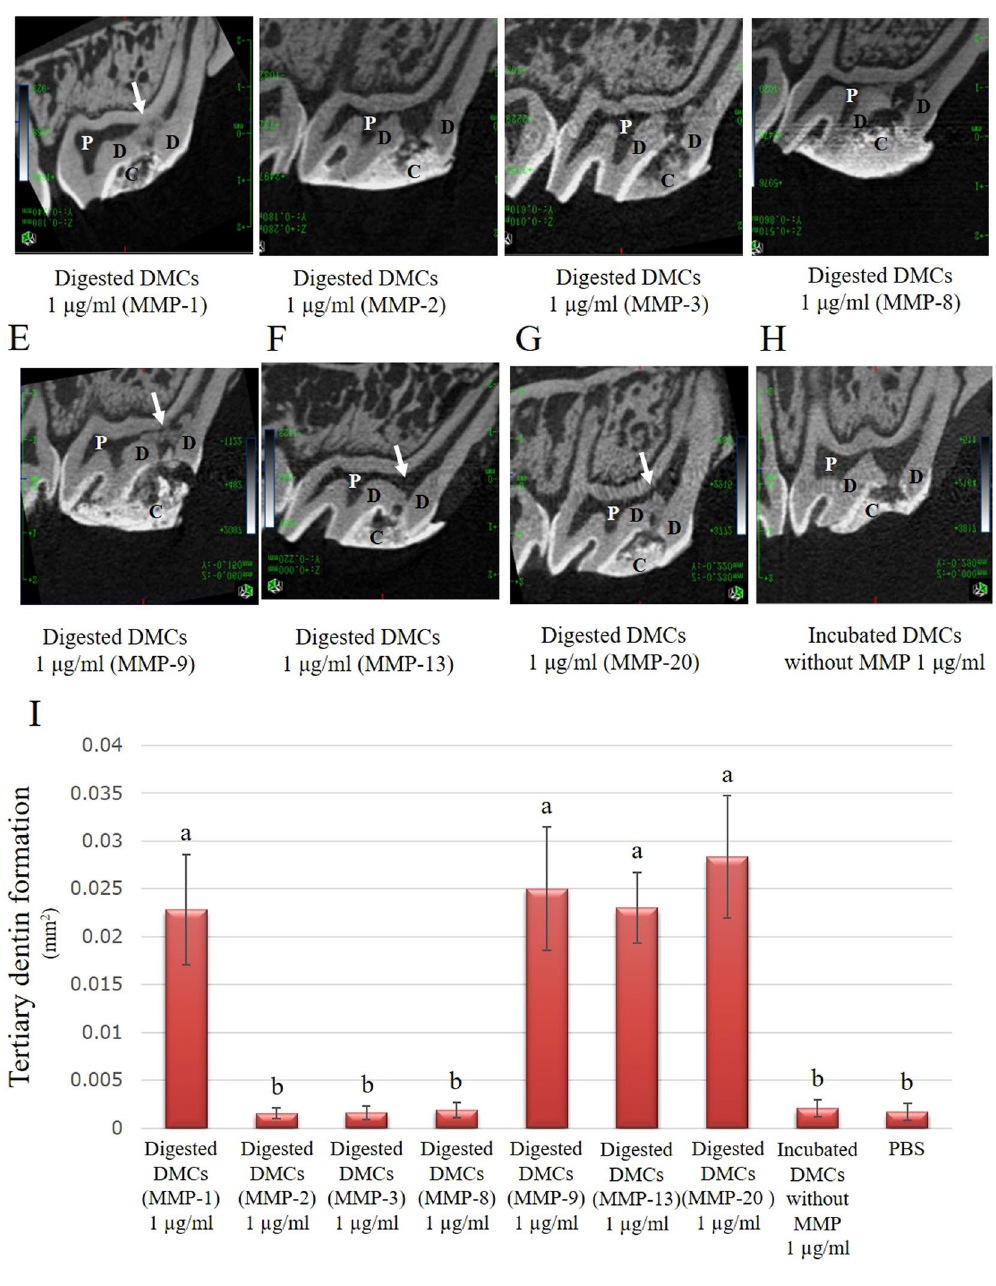
Figure 7. Micro-computed tomography (CT) images of tertiary dentin formation 28 days after direct pulp capping using 1 µ g/ml of dentin matrix components (DMCs) treated with matrix metalloproteinase (MMP)-1 ( A ), MMP-2 ( B ), MMP-3 ( C ), MMP-8 ( D ), MMP-9 ( E ), MMP-13 ( F ), MMP-20 ( G ), or incubated DMCs without MMP ( H ). The tertiary dentin area 28 days after direct pulp capping using 1 µ g/ml of DMCs digested with each MMPs showed in Fig. 7I. Quantification of tertiary dentin formation induced 1 µ g/ml of DMCs treated with MMP-1, -9, -13, or -20 facilitated hard tissue formation, compared with 1 µ g/ml of DMCs treated with other MMPs or incubated DMCs without MMP. One microgram per millilitre of DMCs treated with MMP-20 induced a significantly thicker tertiary dentin beneath pulp capping materials. One microgram per millilitre of DMCs treated with MMP-1, -9, and -13 induced tertiary dentin with some defect or void space beneath pulp capping materials. These data represent six independent experiments. C = cavity, D = dentin, P = pulp. White arrow = dentin